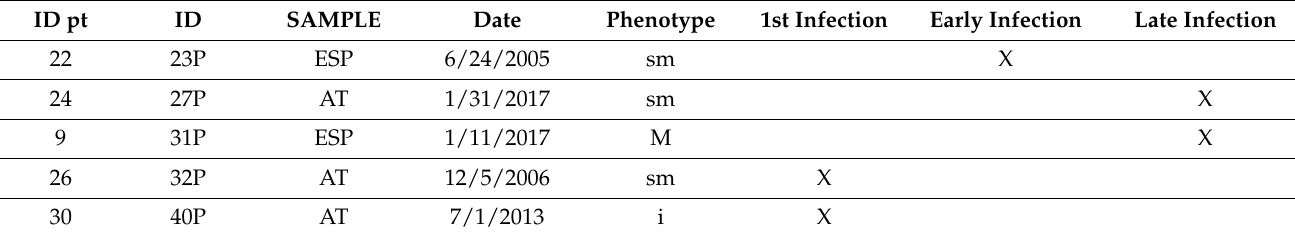
Table 2. The five P. aeruginosa clinical isolates and their characterization by several properties [41]. ID